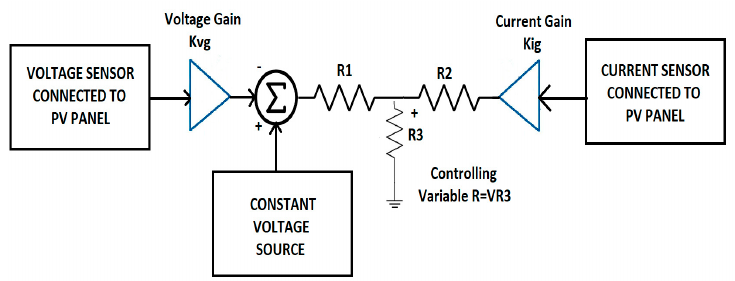
Figure 4. Circuit to generate the controlling variable R.